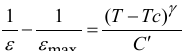
Figure 10. Variation of ln(1/ε’ - 1/ε’ PEZT at 10 6 Hz.